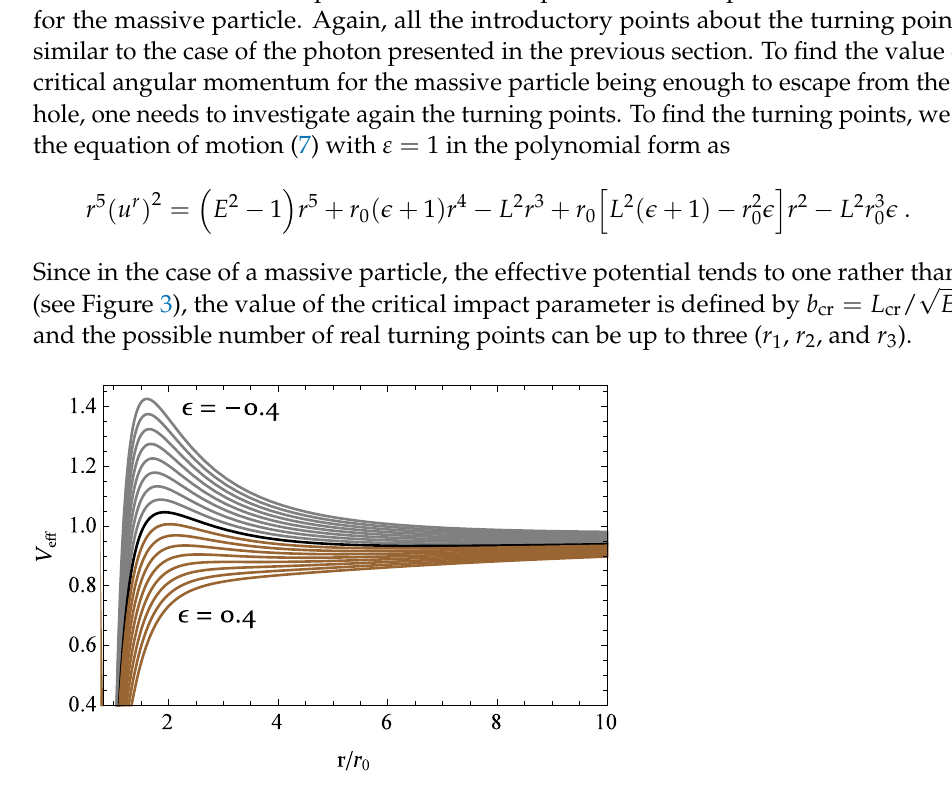
Figure 3. The same as the left panel of Figure 1, but for the massive